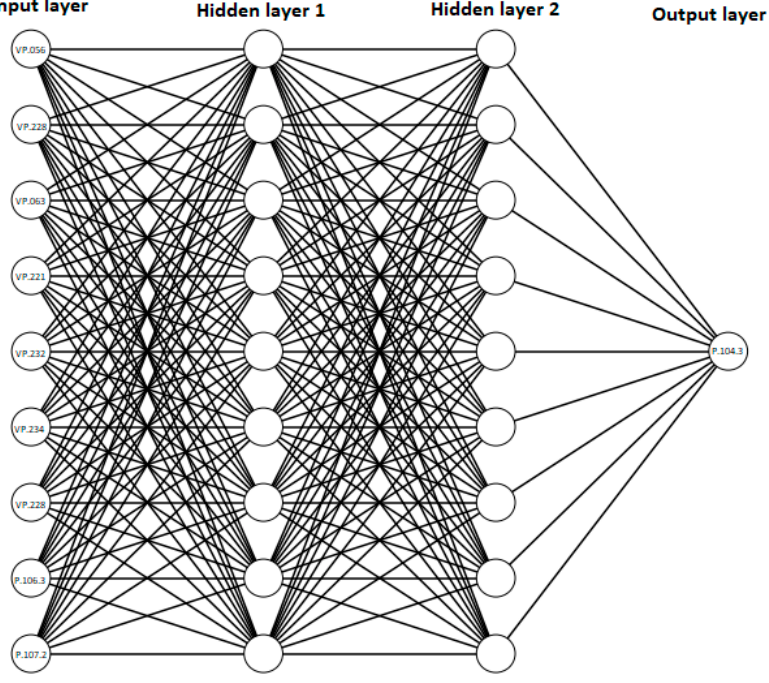
Figure 3. Neural network configuration with two hidden layers.